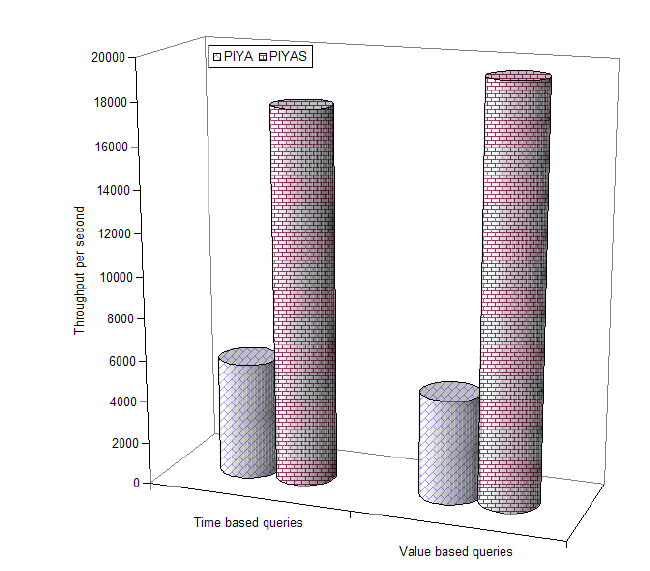
Figure 10. Data throughput per second from